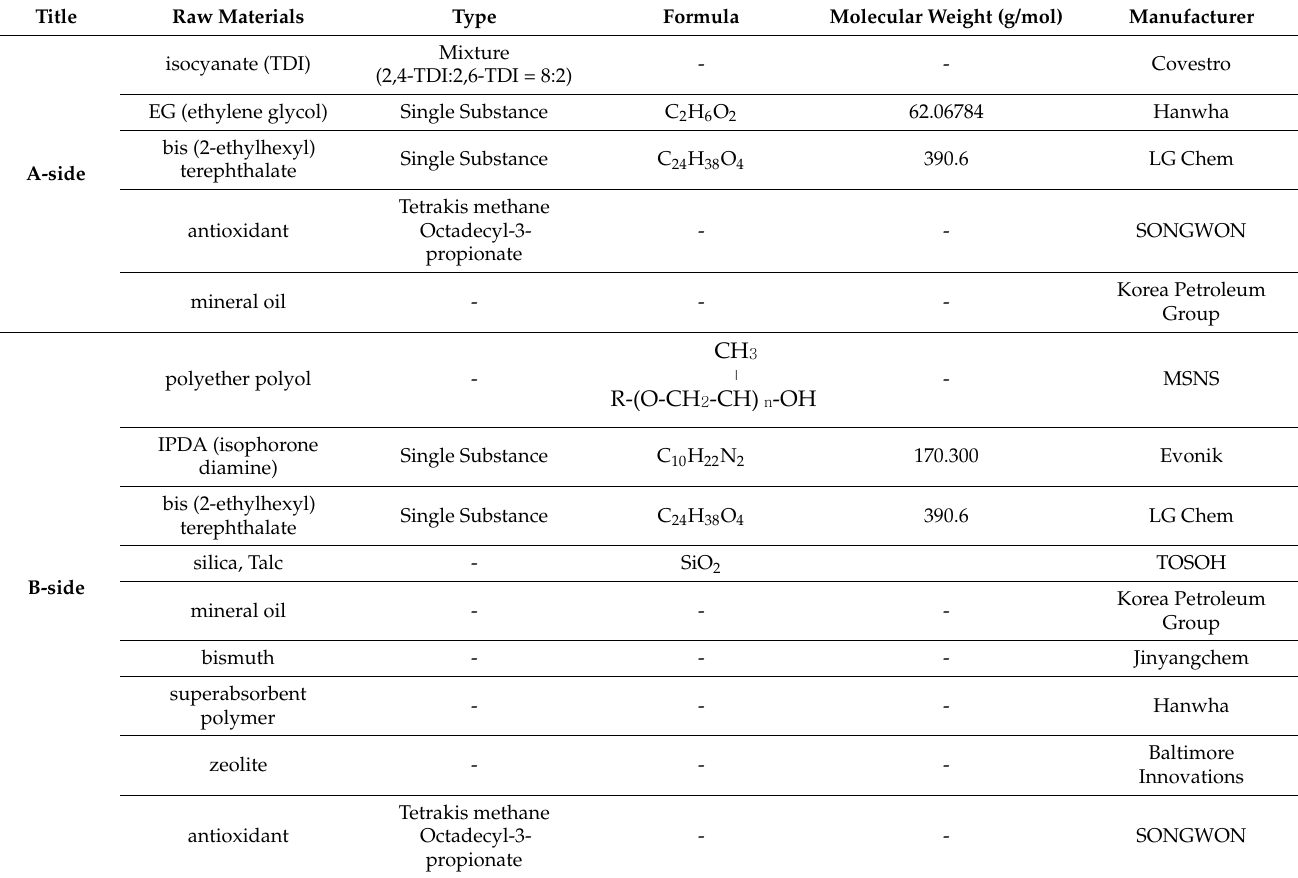
Table 2. The chemical composition of raw materials.